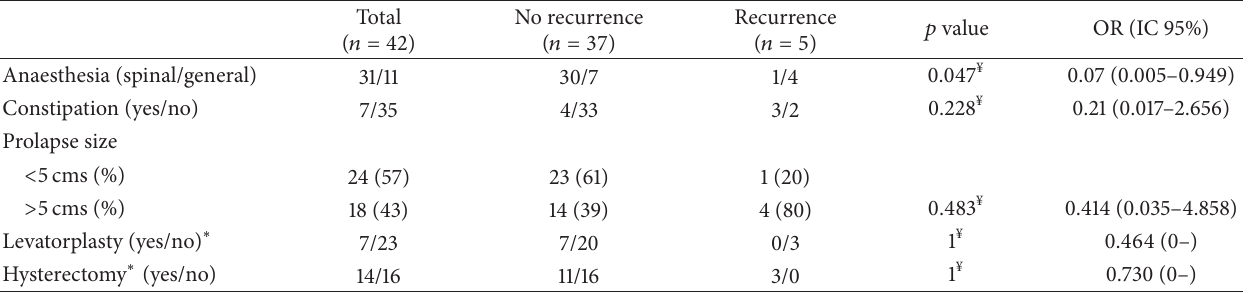
Table 2: Multivariate